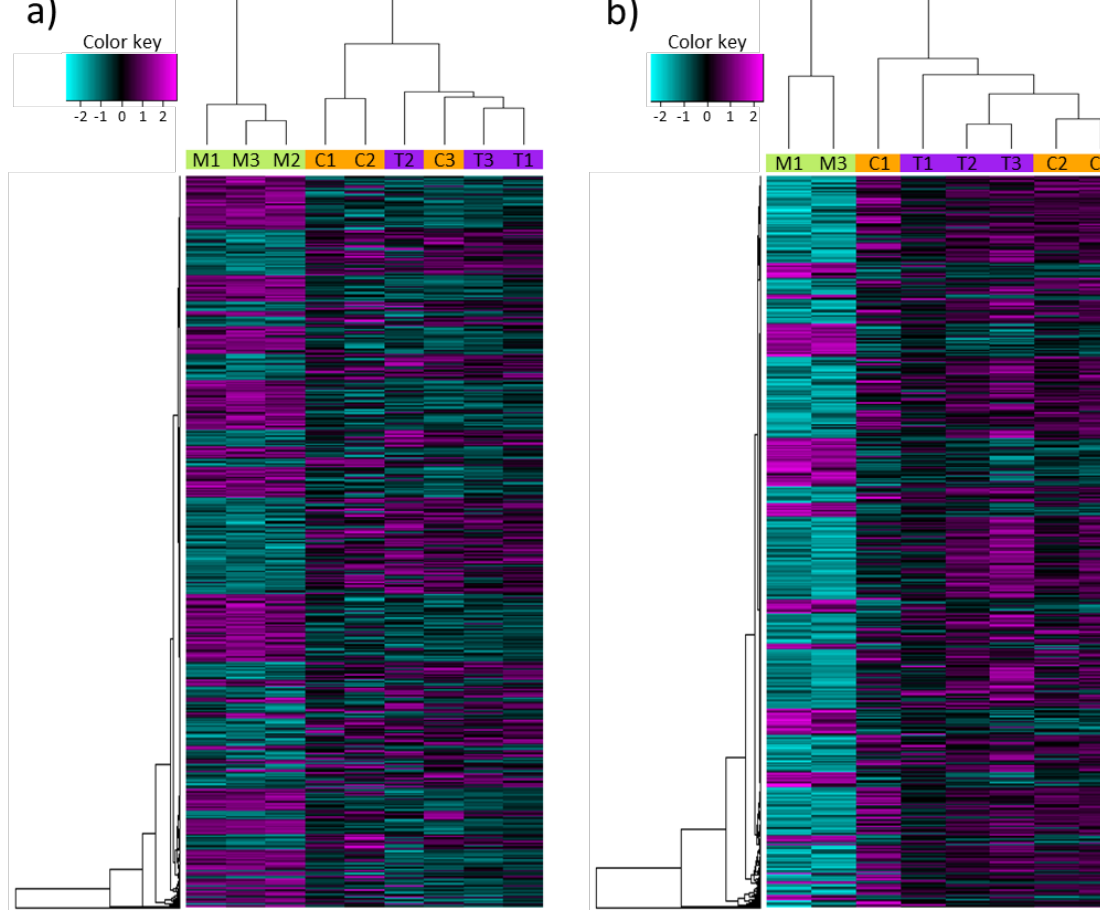
Figure 3. Hierarchical clustering of all differentially expressed genes (DEGs) in Myzus persicae feeding on CaMV- and TuYV-infected Arabidopsis thaliana (a) and Camelina sativa (b), compared to mock- inoculated control plants (Mock-inoculated [M], TuYV-infected [T] and CaMV-infected [C]) (Supplementary Dataset S1). The color key scale displays the row Z-score (normalized counts) from -2 to +2 as a gradient from cyan to